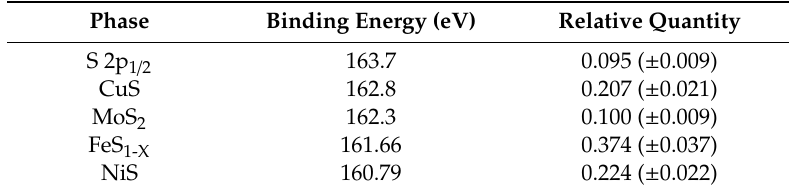
Table 2. Binding energies and relative quantity of compounds for S 2p 3 / 2 spectra of Steel C after immersion for four